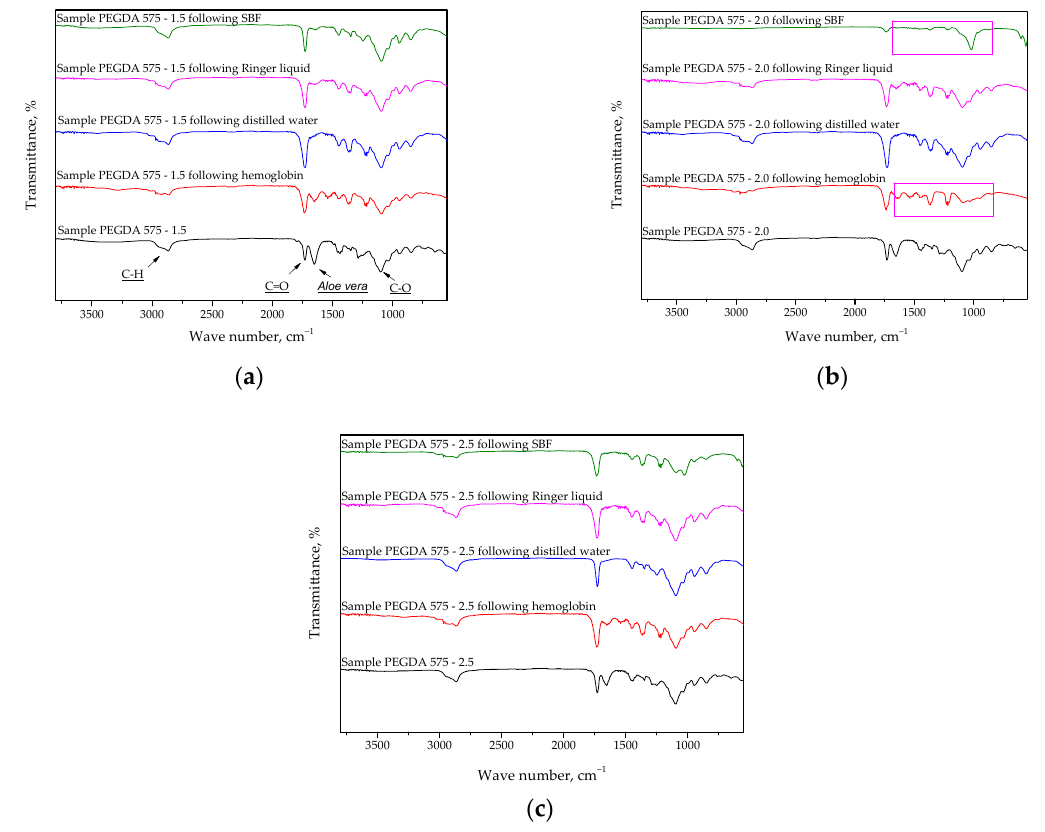
Figure 7. FT-IR spectra showing the influence of incubation on the structure of hydrogels obtained using varying amounts of PEGDA 575, i.e., 1.5 mL ( a ), 2.0 mL ( b ) and 2.5 mL ( c ).